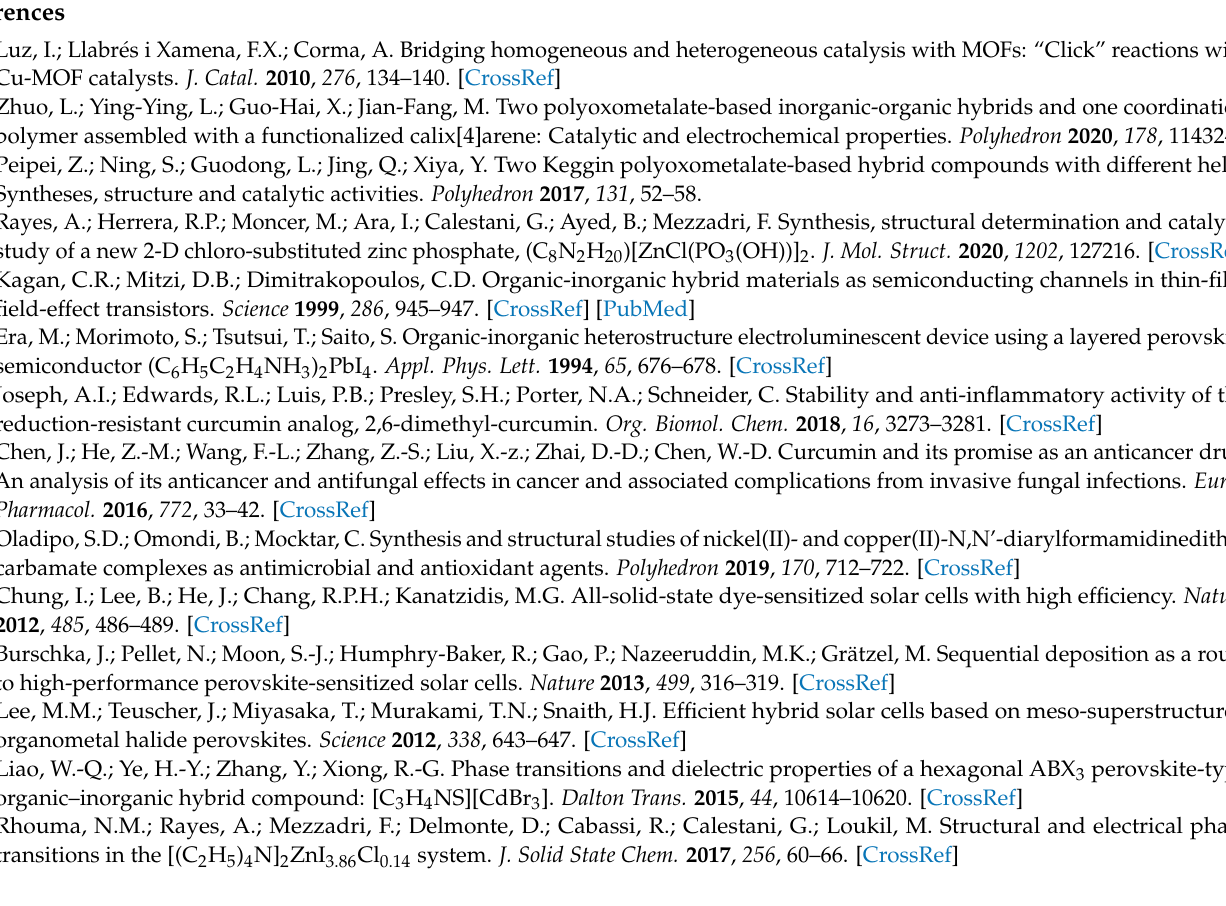
Figure S3: 1 H and 13 C-APT (CD 3 CN) NMR spectra of 1-(bis(pentyloxy)methyl)-3-nitrobenzene 7ae , Figure S4: 1 H and 13 C-APT (CD 3 CN) NMR spectra of 1-(bis(pentyloxy)methyl)-4-nitrobenzene 7be , Figure S5: 1 H and 13 C-APT (CD 3 CN) NMR spectra of 1-(bis(pentyloxy)methyl)-3-chlorobenzene 7ce , Figure S6: 1 H and 13 C-APT (CD 3 CN) NMR spectra of 1-(bis(pentyloxy)methyl)-3-bromobenzene 7de , Figure S7: 1 H and 13 C-APT (CD 3 CN) NMR spectra of 1-(bis(pentyloxy)methyl)-4-bromobenzene 7ee , Figure S8: 1 H and 13 C-APT (CD 3 CN) NMR spectra of 4-(bis(pentyloxy)methyl)benzonitrile 7fe , Figure S9: 1 H and 13 C-APT (CD 3 CN) NMR spectra of 1-(bis(pentyloxy)methyl)-4-(trifluoromethyl) benzene 7ge , Figure S10: 1 H and 13 C-APT (CD 3 CN) NMR spectra of (bis(pentyloxy)methyl)benzene 7he , Figure S11: 1 H and 13 C-APT (CD 3 CN) NMR spectra of 1-(bis(pentyloxy)methyl)-4-metho- xybenzene 7ie